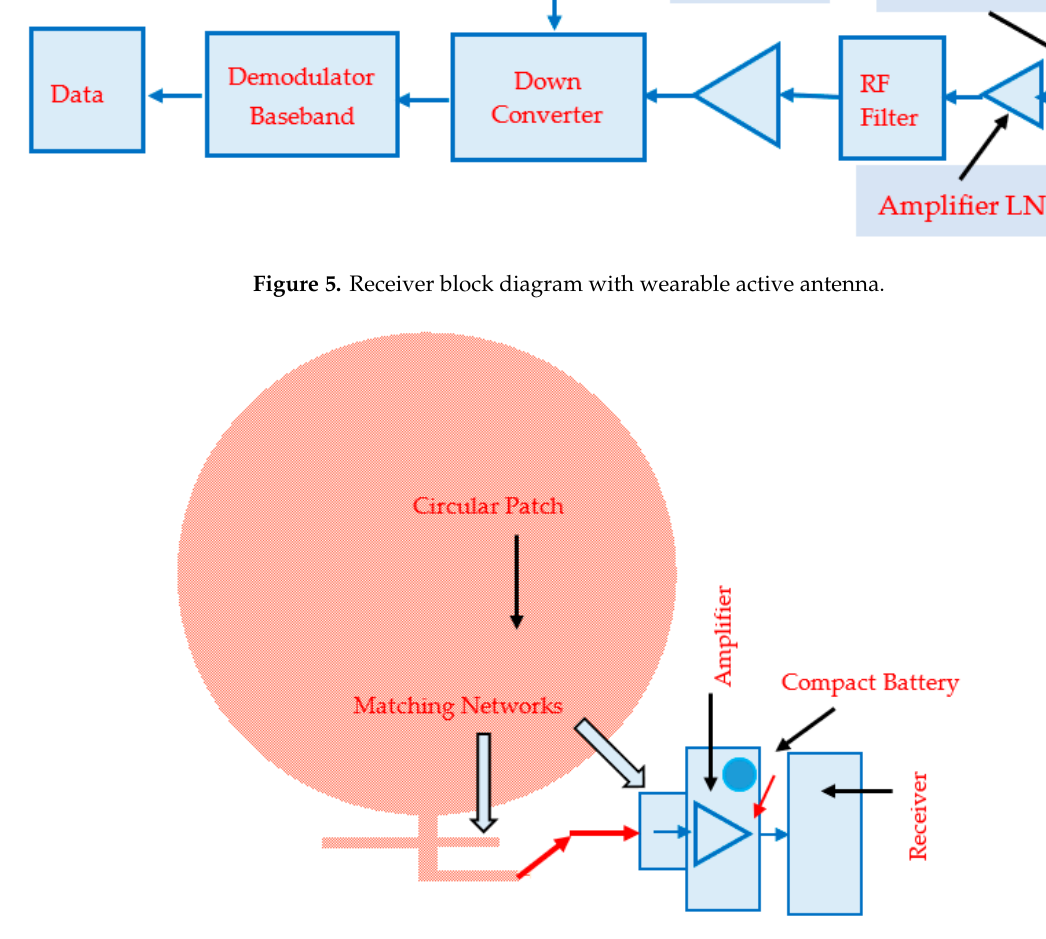
Figure 6. Circular Wearable Active Receiving Patch antenna for Medical and 5G Applications.